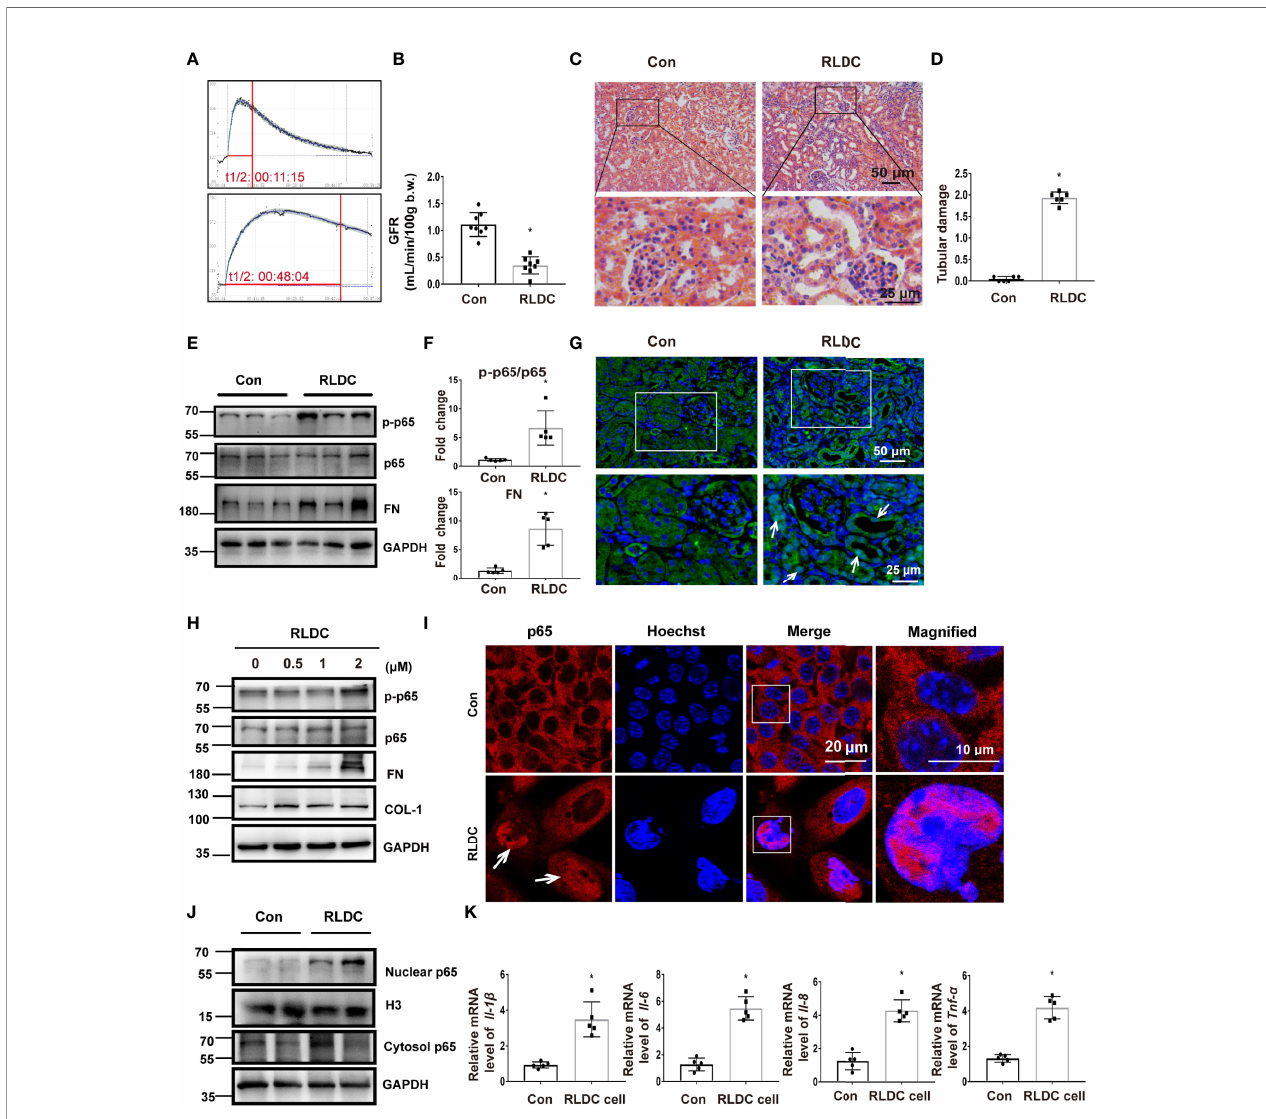
FIGURE 1 | RLDC treatment induces chronic kidney injury and activates NF- k B during maladaptive kidney repair. (A – G) Male C57BL/6 mice were injected weekly with 8 mg/kg cisplatin for 4 weeks to collect samples 1 month later. (A) The elimination pro fi le of transdermal FITC-sinistrin was monitored. (B) GFR measurement by monitoring transcutaneous FITC-sinistrin clearance (n=8). (C) Representative histology images of hematoxylin-eosin staining of kidney tissues (n=6). (D) Pathological score of tubular damage. (E) Representative immunoblots of p-p65, p65, FN, and GAPDH (loading control) in kidney tissues (n=5). (F) Densitometry of p-p65, p65 and FN. (G) Immuno fl uorescence analysis of p65 (n=5). Right two images were magni fi ed from the boxed areas. (H – K) BUMPT cells were incubated with indicated concentrations of cisplatin for 7h each day for 4 days, and collected at day 5. (H) Representative immunoblots of p-p65, p65, FN, COL-1 and GAPDH